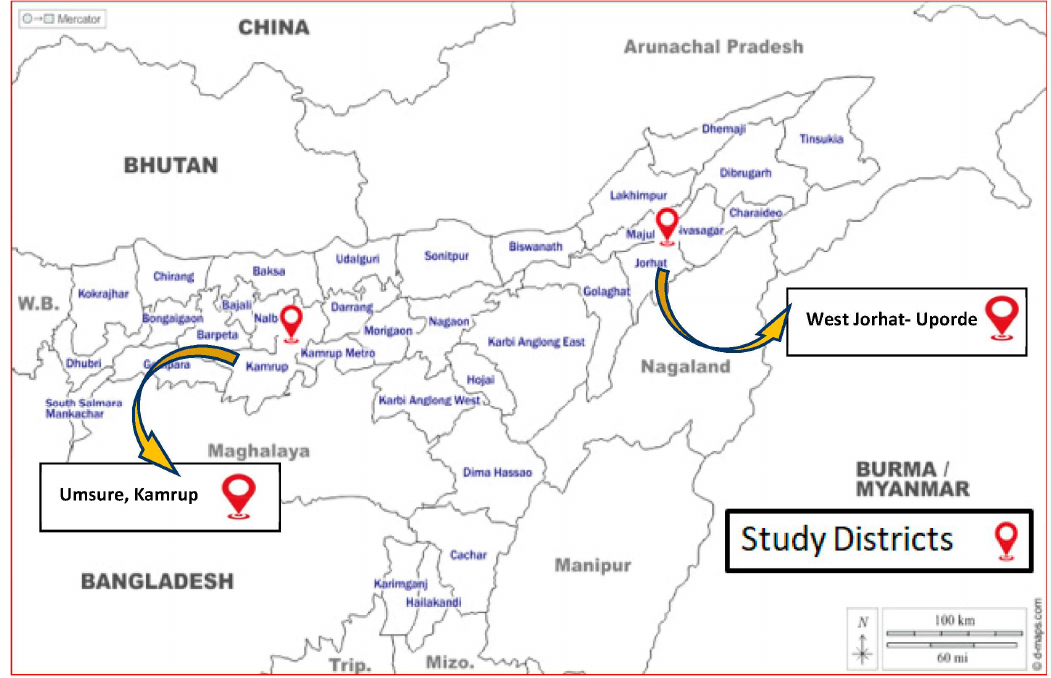
Figure 1. Demonstration of the geographical area where samples or specimens were collected for the current study. Here, the Assam, India, districts of Kamrup and Jorhat were chosen due to their high sales of pigs and pig products and as they are JE hotspot